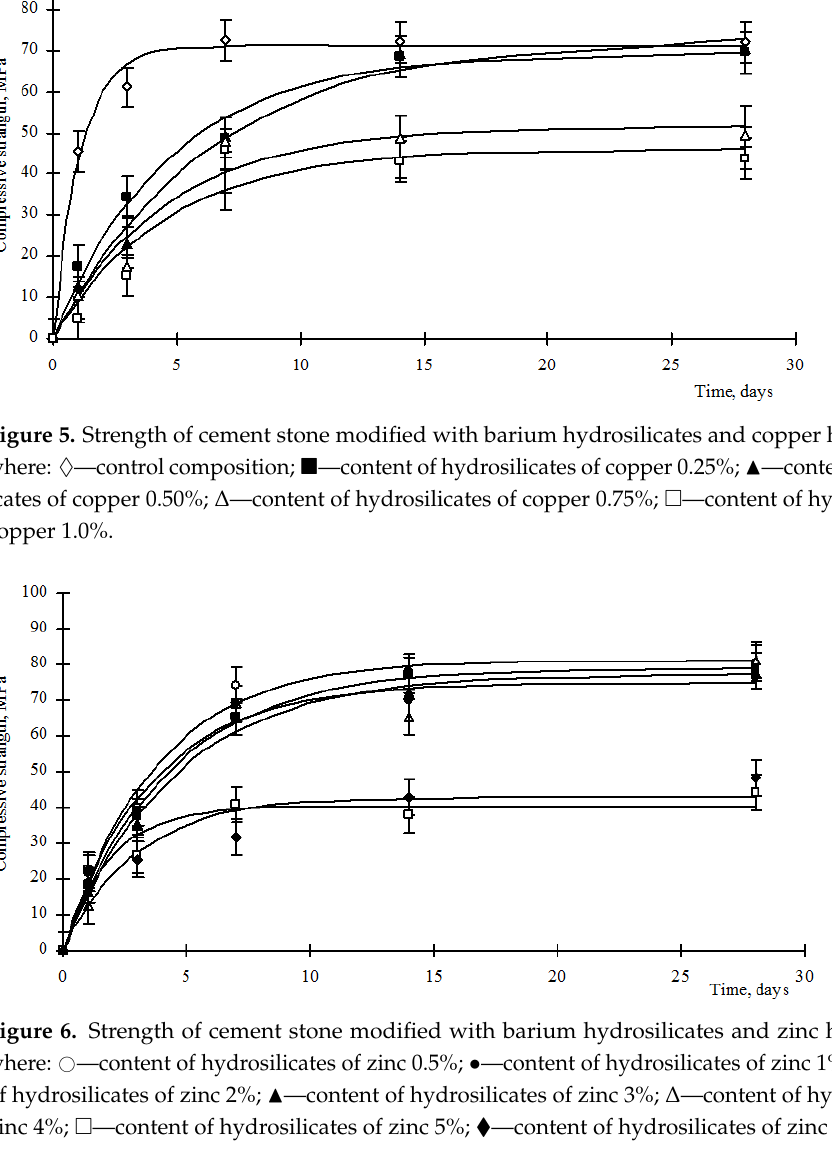
Table 4. Empirical coefficient values.